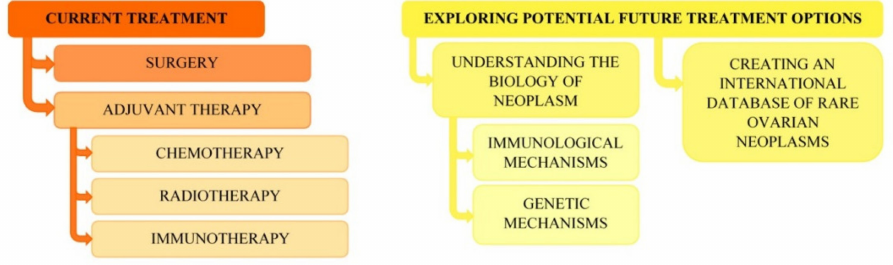
Figure 1. Diagram of current treatment and potential future treatment options in rare primary ovarian